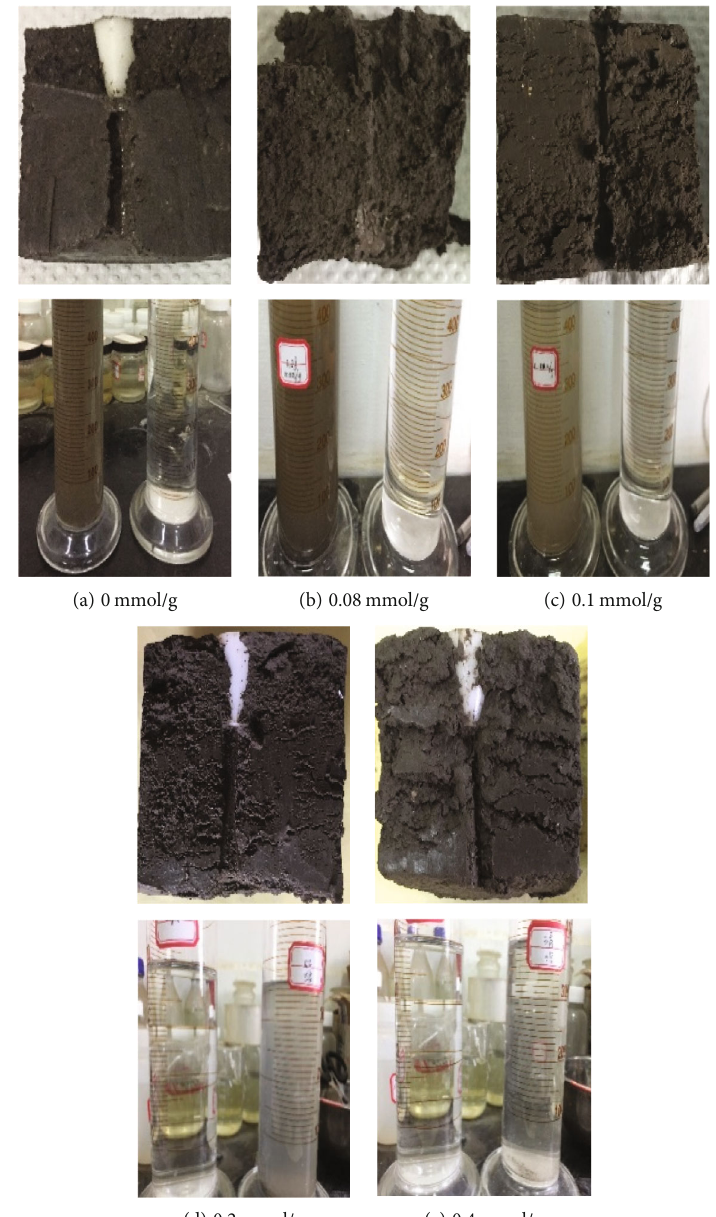
Figure 8: Pinhole test before and after modi fi cation with di ff erent dosages of hydroxyl